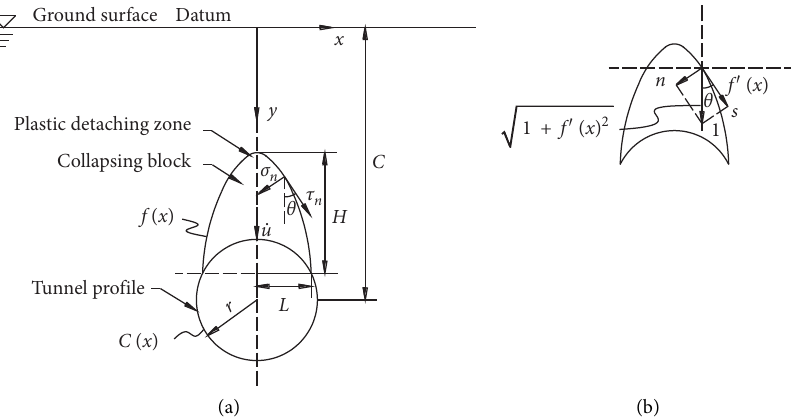
Figure 2: Collapse mechanism of rock mass for tunnels in steady seepage field. (a) Schematic diagram of collapse mechanism. (b) Geometric condition of detaching